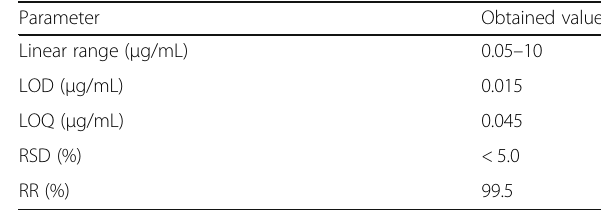
Table 3 Validation